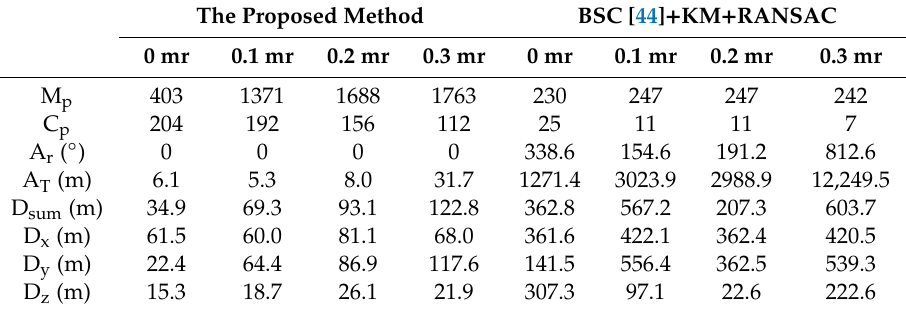
Table 8. Registration errors of point clouds with di ff erent